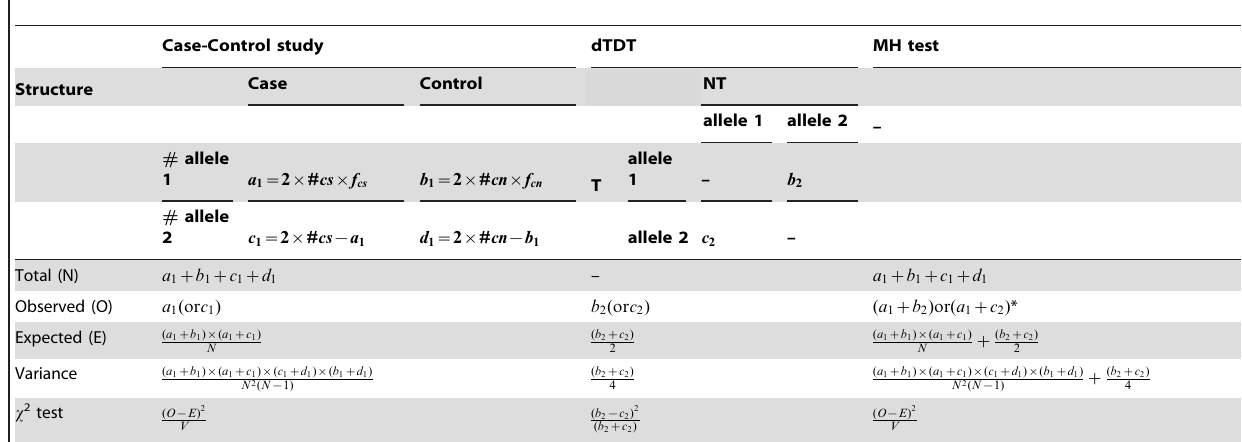
Table 7. Calculations of Observed & Expected values, Variance, x 2 test in Case-Control study, dTDT and MH